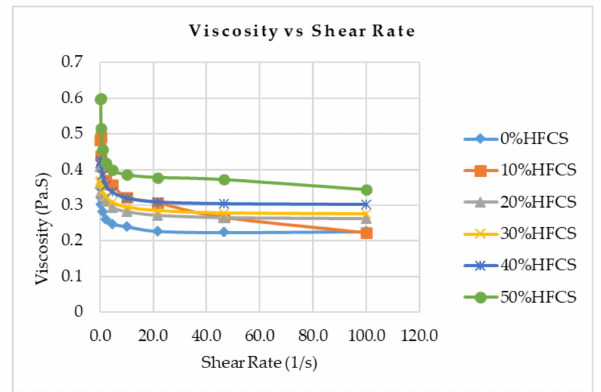
Figure 1. Effect of HFCS adulteration on the viscosity of adulterated KH at a different shear rate.